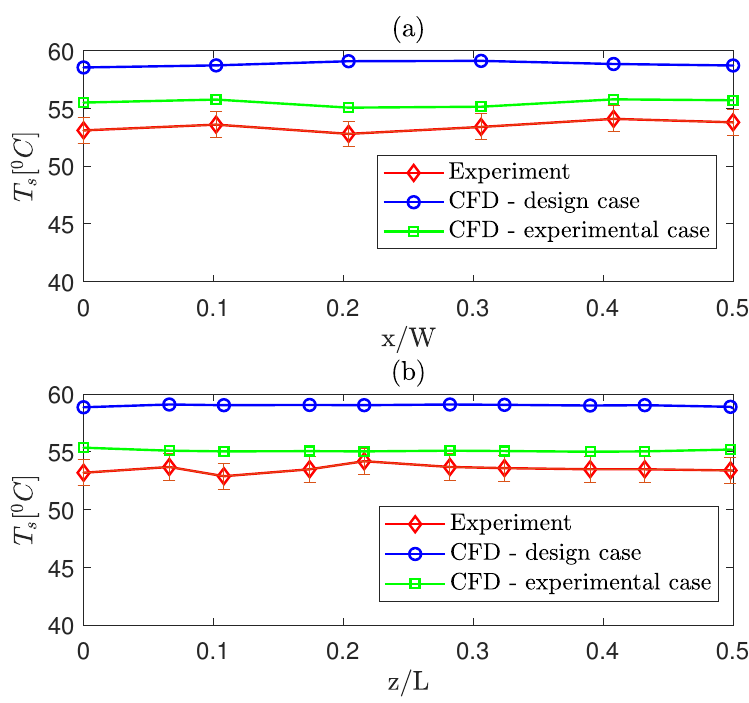
Figure 12. Comparison of the numerical and experimental results for the base temperature of the heat sink taken in the transverse ( a ) and longitudinal ( b ) directions above the LED circuit board. The measurement locations and directions are shown in Figure 10. The error bars on the measurements correspond to the manufacturer’s stated accuracy of ± 2% for the thermal camera (For the design case, Q d = 282 Watts and for the experiment, Q e = 240 Watts).